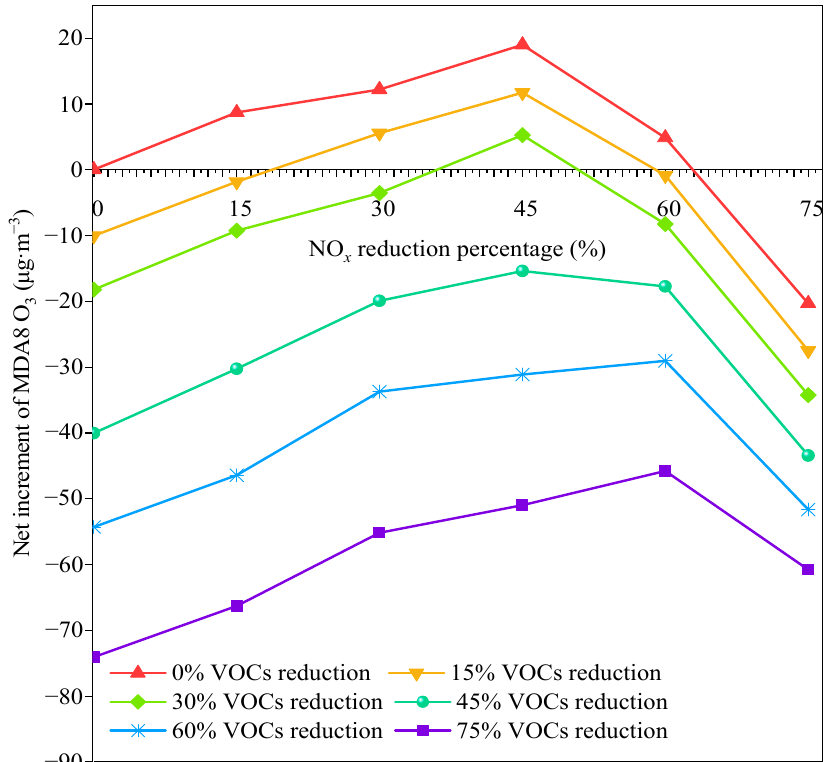
Figure 9. Net increment of MDA8 O 3 as a function of the reduction percentages of NO x and VOCs in downtown Handan during June 2018.